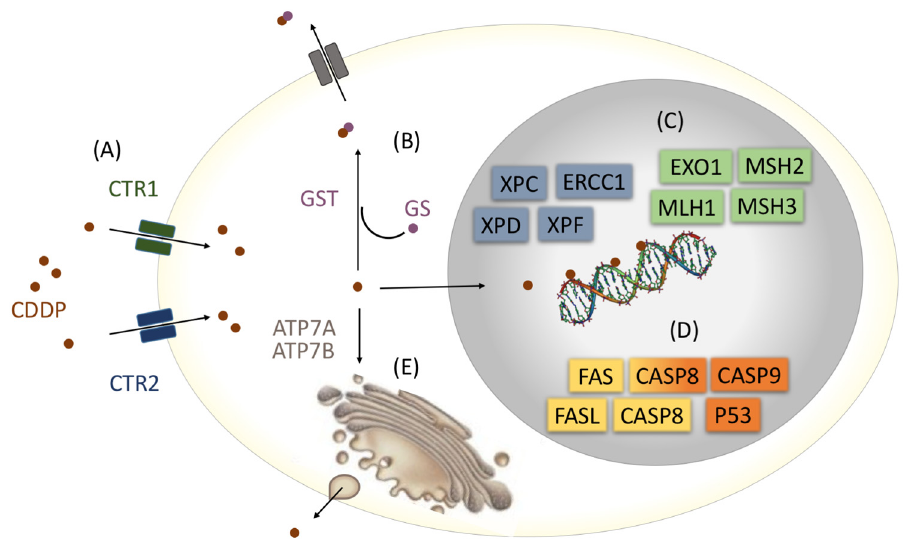
Figure 1. Main pathways related to cisplatin (CDDP) influx (A), detoxification (B), DNA repair (C), apoptosis (D), and efflux (E). CDDP influx occurs through copper transport receptors 1 (CTR1) and 2 (CTR2). The glutathione S-transferases (GSTs), mu1 (GSTM1), theta1 (GSTT1), and Pi1 (GSTP1) conjugate CDDP with glutathione (GS) and enable its elimination. The DNA lesion induced by CDDP can be removed through the nucleotide excision repair (NER) pathway, mediated by the xeroderma pigmentosum ( XPC, XPD , and XPF ) and excision repair cross-complementation group 1 ( ERCC1 ) genes, as well as by the mismatch repair (MMR) pathway mediated through proteins encoded by MutL homolog 1, 2, and 3 ( MLH1 , MSH2 , and MSH3 , respectively) and exonuclease 1 ( EXO1 ) genes. If the repair is not effective, the apoptosis of cells is mediated by proteins encoded by the TP53 , CASP8 , CASP9 , CASP3 , Fas cell surface death receptor ( FAS ), and Fas ligand ( FASL ) tumor necrosis factor genes. CDDP efflux is mediated via ATPase copper transporters alpha (ATP7A) and beta (ATP7B) (Adapted from Kuo et al. 2007